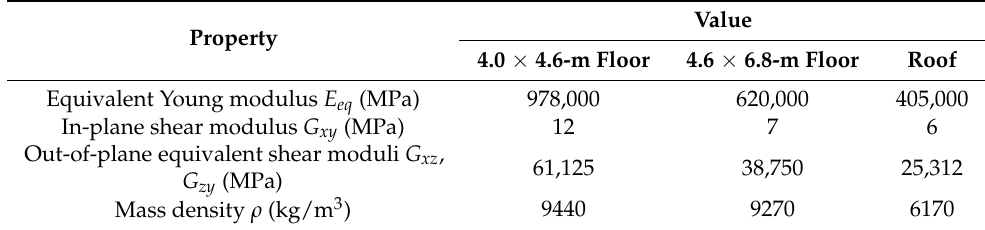
Table 2. Properties of the shell elements (thickness = 18 mm) representing the flexible diaphragms in configuration B1-AB. Reprinted from Reference [41].